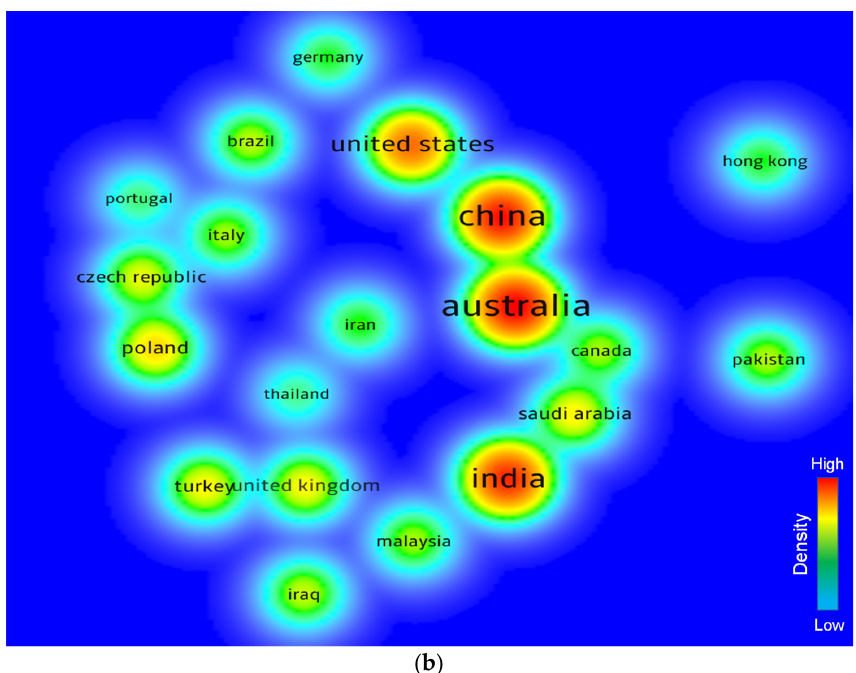
Figure 9. Systematic map of participating countries: ( a ) scientific visualization; ( b ) density.